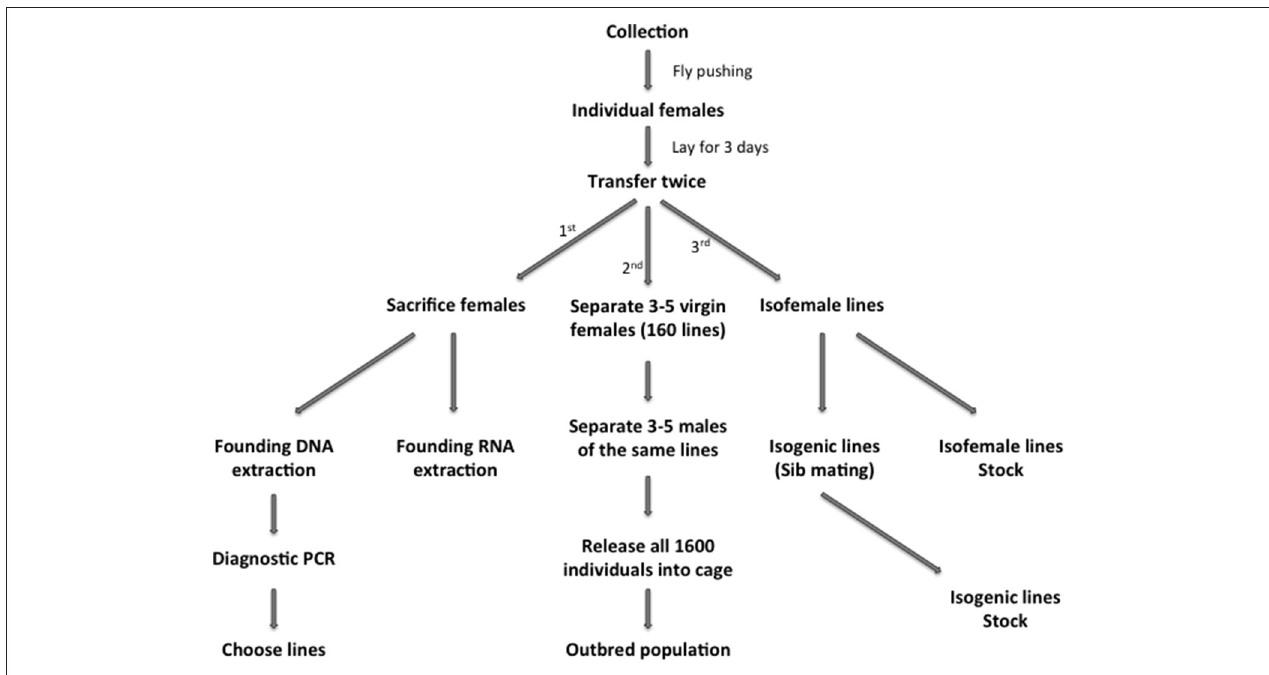
FIGURE 2 | Pipeline of how to establish Drosophila laboratory resources upon collection from nature.